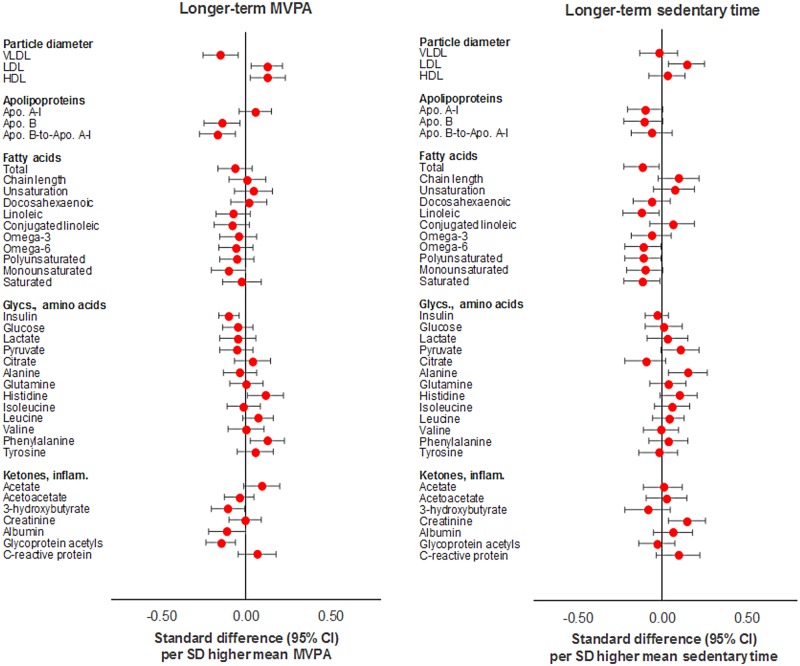
Mutually adjusted associations of longer-term MVPA and sedentary time with lipoprotein particle diameter, apolipoproteins, fatty acids, glycolysis factors, amino acids, ketones, and inflammatory factors at age 15y in ALSPAC.Metabolic traits are in standardised units. Longer-term MVPA/sedentary time defined as mean of 3 measures (at age 12y, 14y, and 15y). Models are adjusted for age, sex, ethnicity, maternal education, device wear time and wear month, alternative measure (MVPA or sedentary time) based on mean across 3 measures, and fat mass index based on mean across 3 measures. ALSPAC, Avon Longitudinal Study of Parents and Children; MVPA, moderate-to-vigorous physical activity.